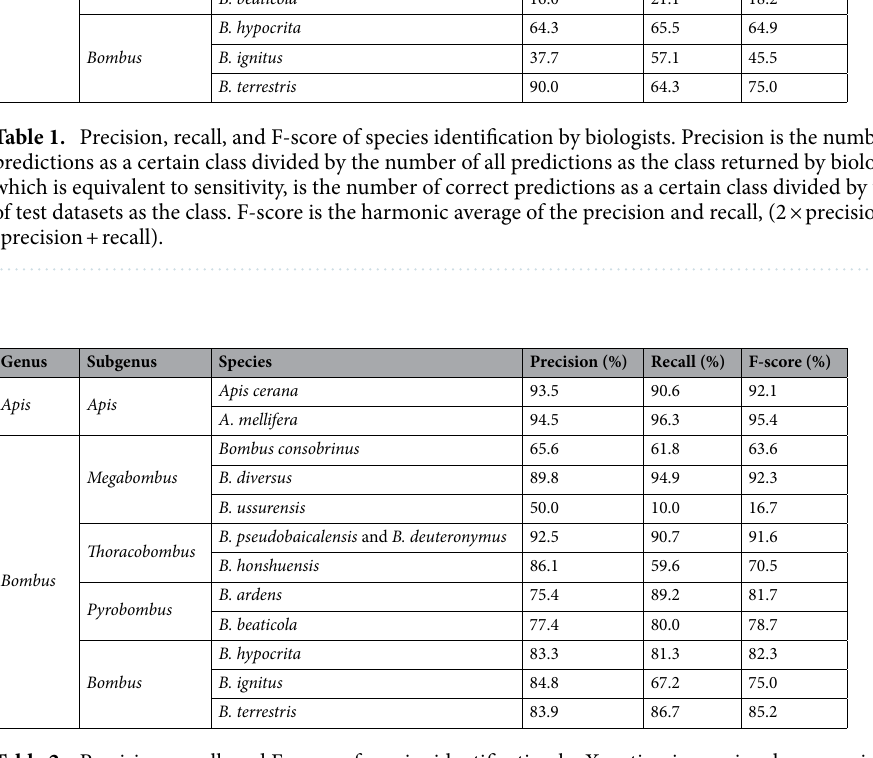
Table 2. Precision, recall, and F-score of species identification by Xception in species class experiment. Precision is the number of correct predictions as a certain class divided by the number of all predictions as the class returned by Xception. Recall, which is equivalent to sensitivity, is the number of correct predictions as a certain class divided by the number of test datasets as the class. F-score is the harmonic average of the precision and recall, (2 × precision × recall)/(precision +